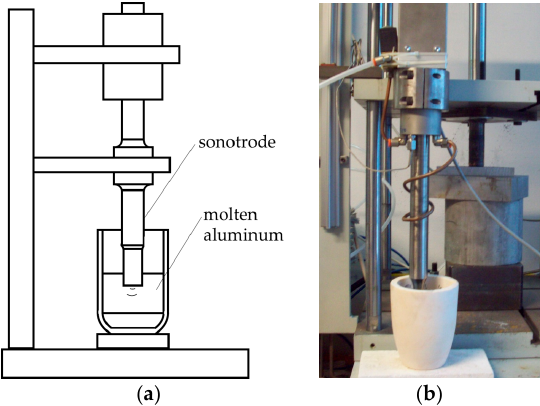
Figure 1. Sketch ( a ) and view of the of the ultrasound US apparatus ( b ) for the treatment of molten